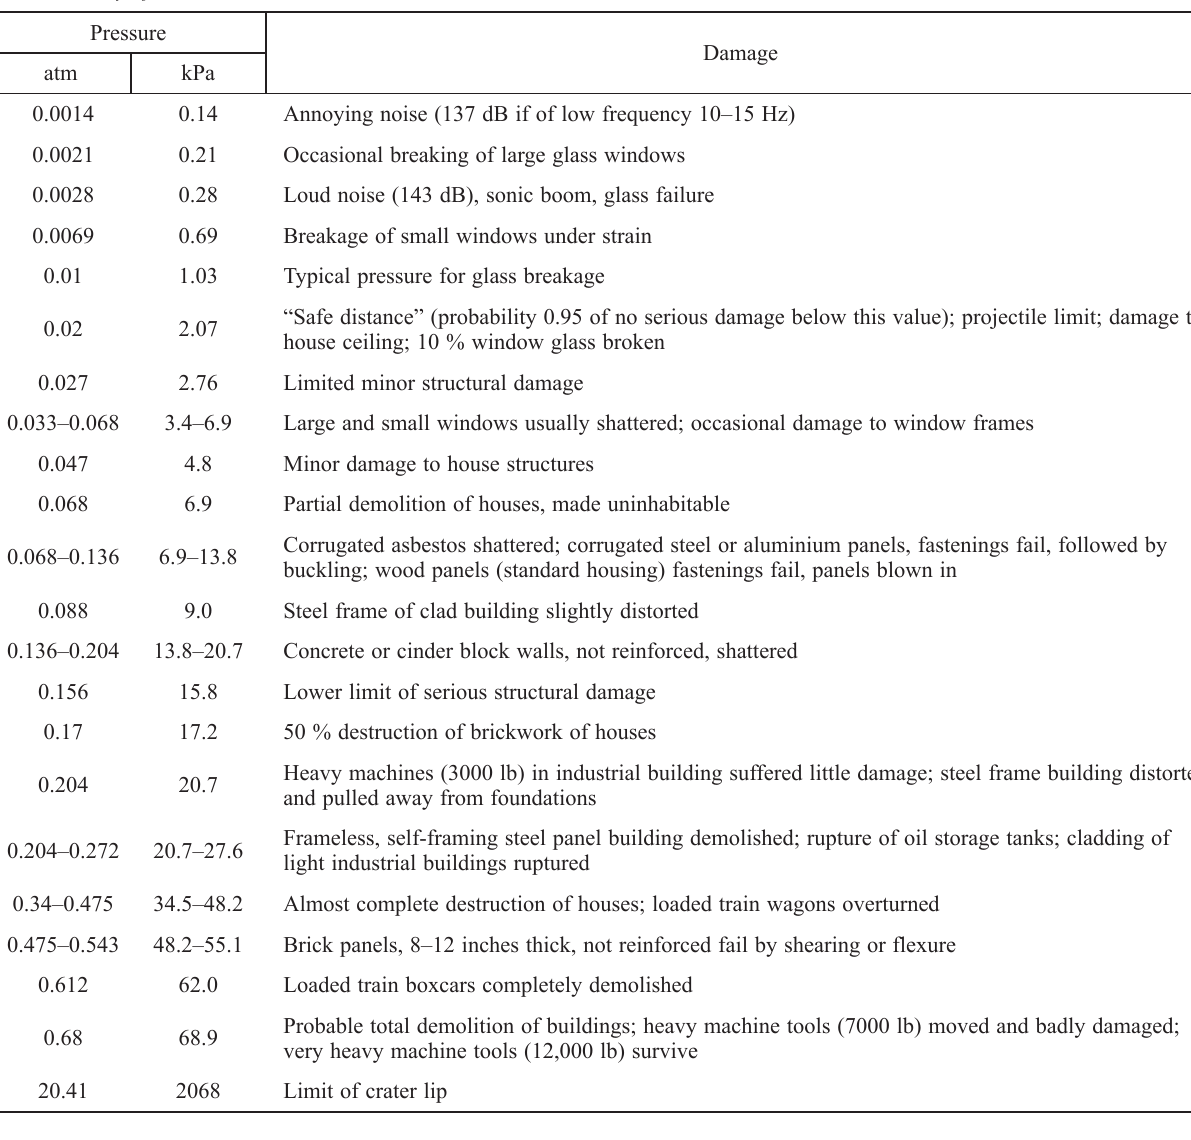
Table 6 – Damage estimates for common structures based on the explosion-induced overpressure. Adapted from AIChE 1 by courte- sy of